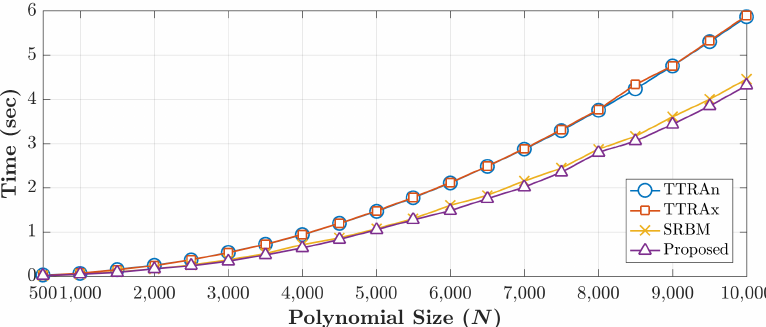
Figure 6. Computation time of the proposed and existing